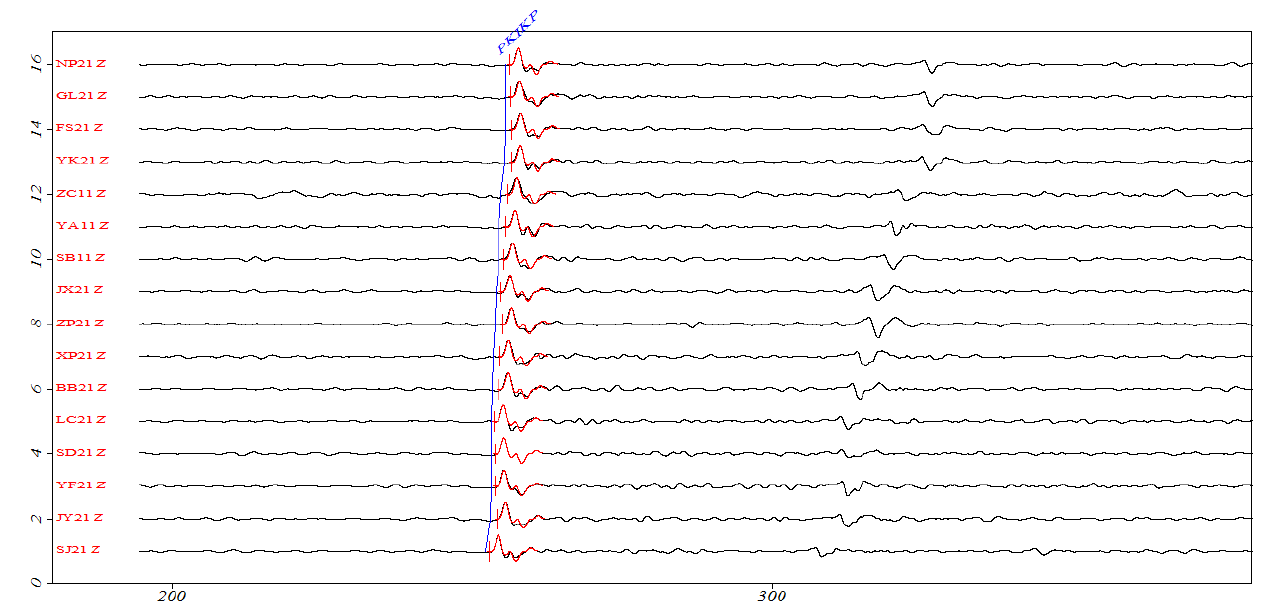
Figure 7. Correlation results of earthquake records in the Alo Islands.